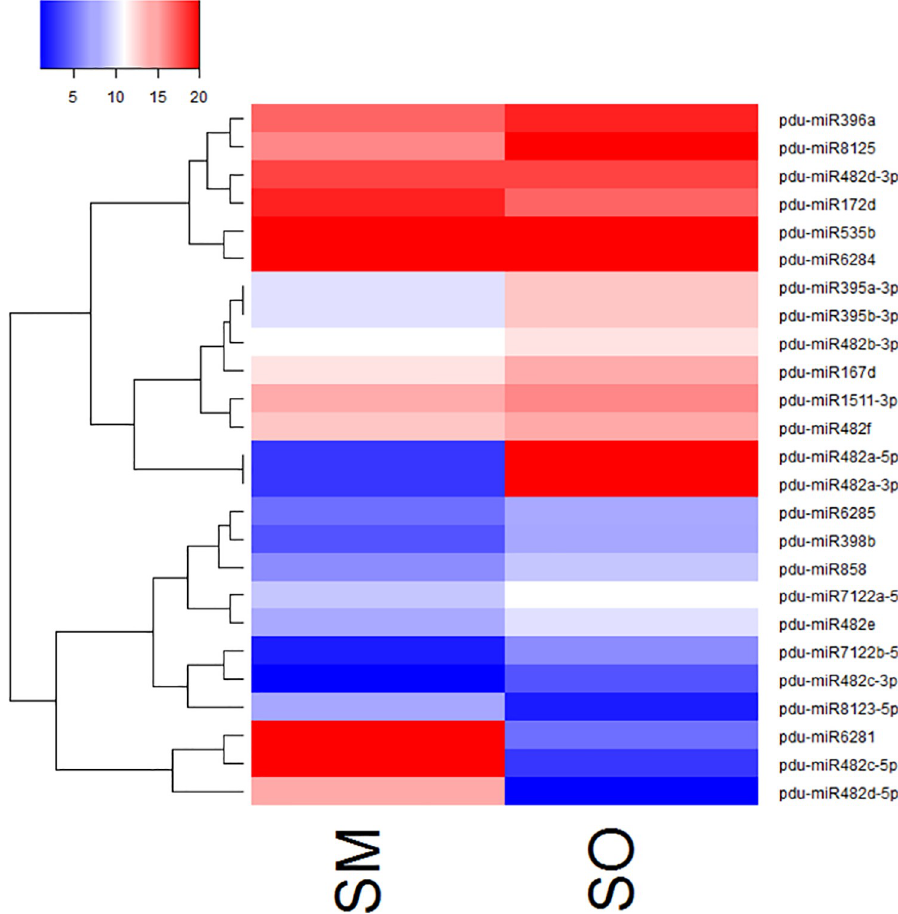
Fig 3. The heatmaps of differentially expressed miRNAs in developing seeds of SM and SO. The color shows the log 2 CPM of miRNAs expression among the SM and SO. As the color gets closer to bright red, increased the expression of